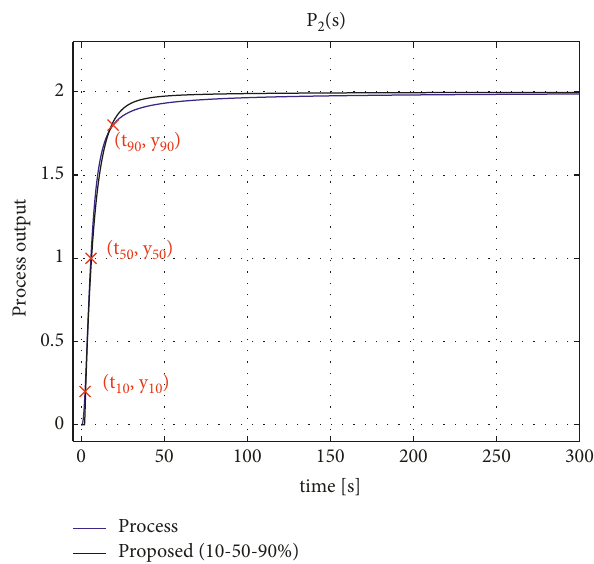
Figure 17: Process reaction curve and FFOPDT model method # 2 (10–50–90%) step response for process P 2 .